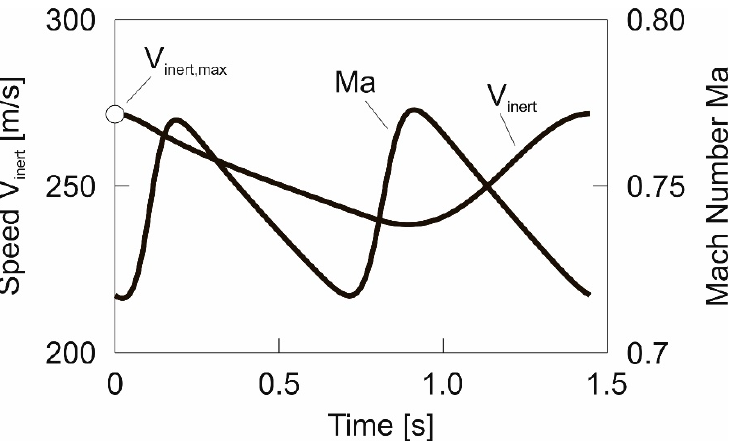
Figure 8. Time histories of speeds, V inert and V a , and Mach number, Ma , of dynamic soaring loop optimized for maximum speed, V inert , max = 271.8